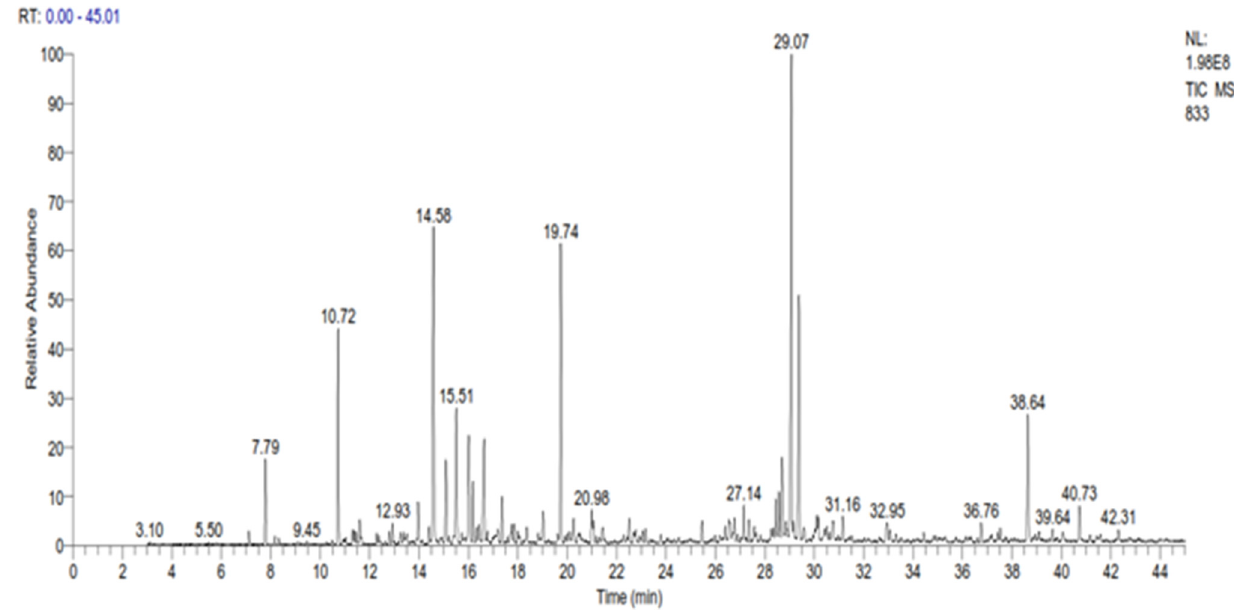
Figure 1. GC Chromatogram of the essential oil of C . ladanifer. Table 2. The compounds identified in the essential oil of C. ladanifer after analysis by GC/MS on column DB-5.